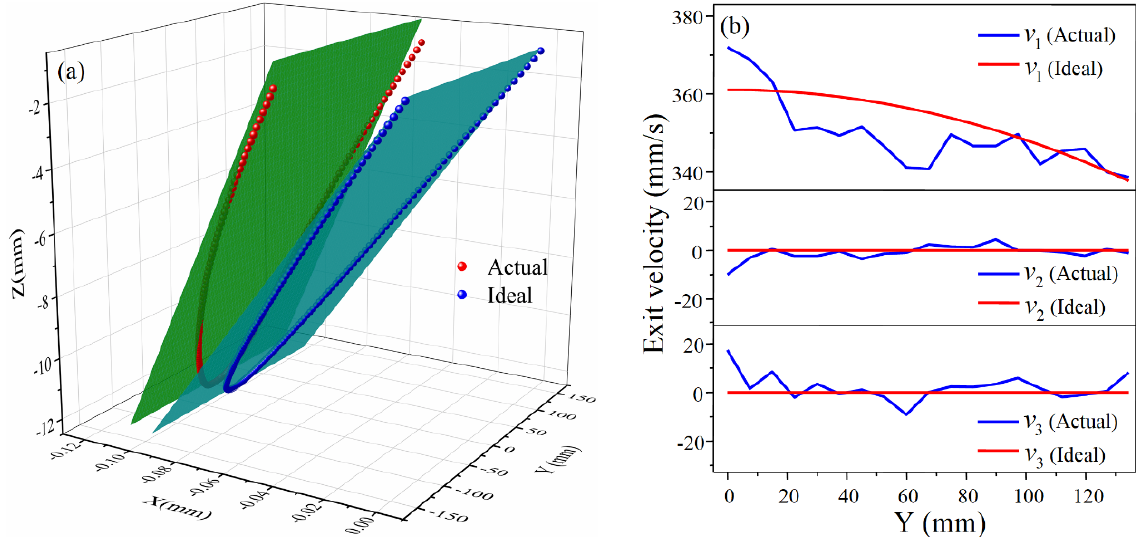
Figure 7. Node distribution of exit cross-section centerline and exit velocity for positive Gaussian curvature surface: ( a ) Node distribution; ( b ) Exit velocity in three directions.